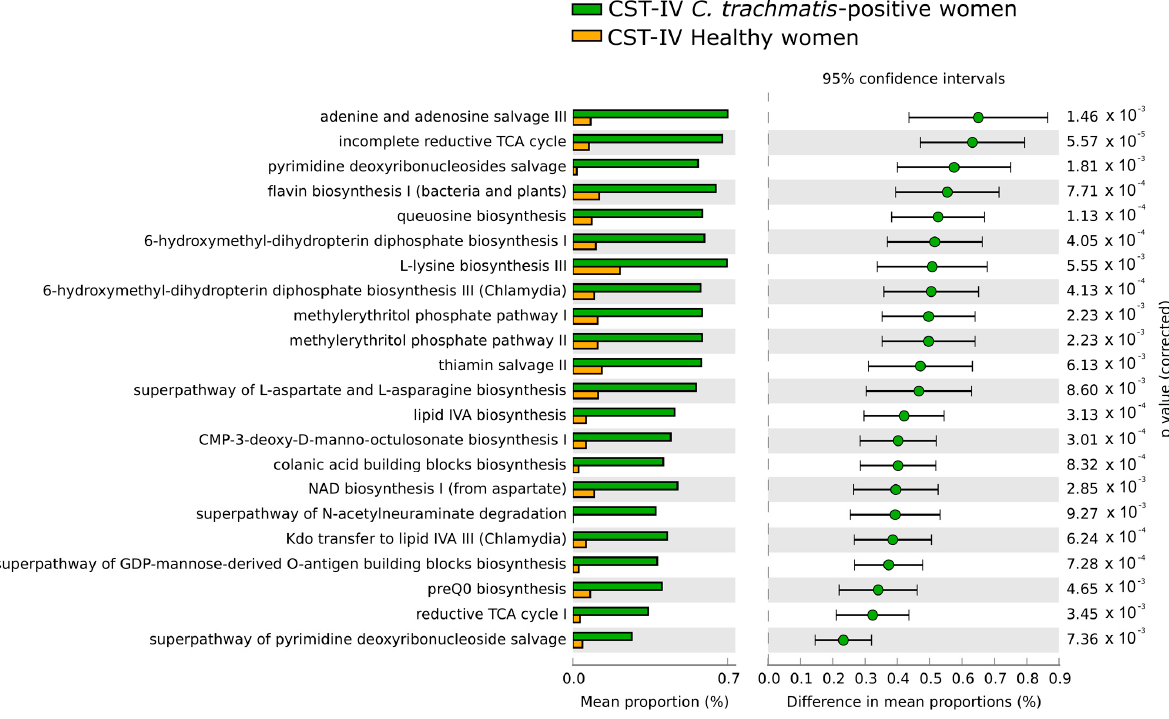
Figure 5. Differences in the composition of predicted metabolic pathways in the CST-IV microbiota between C. trachomatis -positive women and healthy controls. The relative abundance of each pathway was expressed as means ± standard deviations (SD), and statistical significance was calculated by Welch’s t -test.